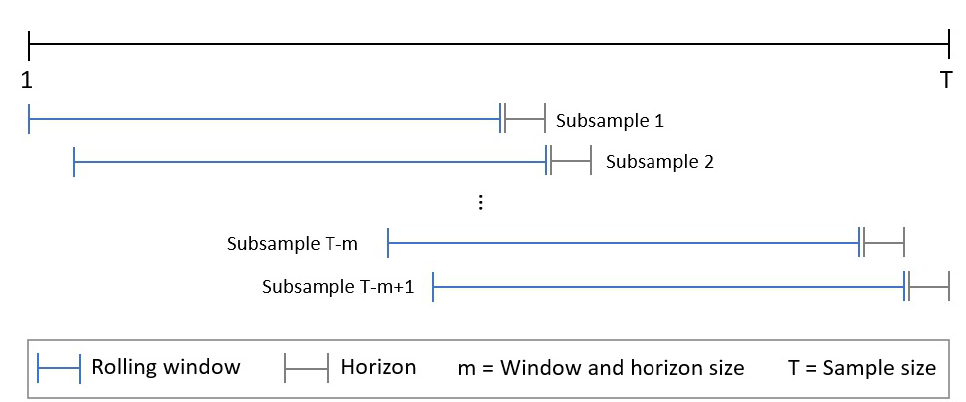
Figure 1. Rolling window